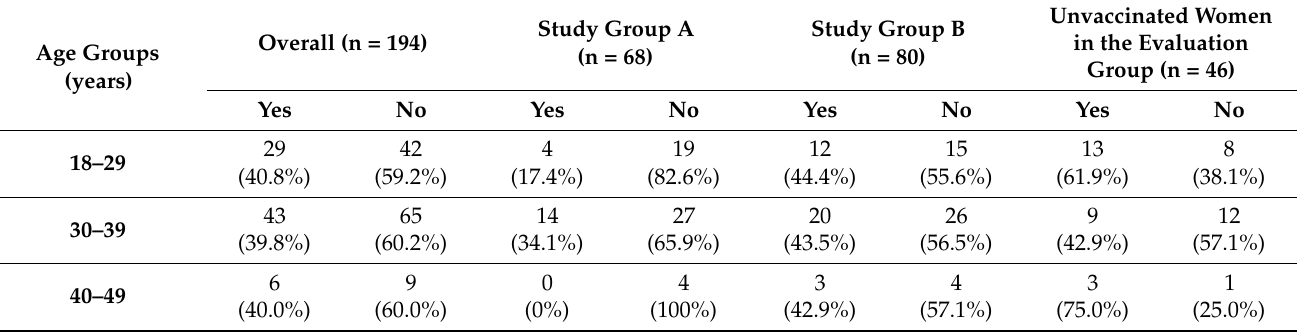
Table 3. Willingness to receive the vaccination among different age groups of study group A, study group B and unvaccinated women of the evaluation group.